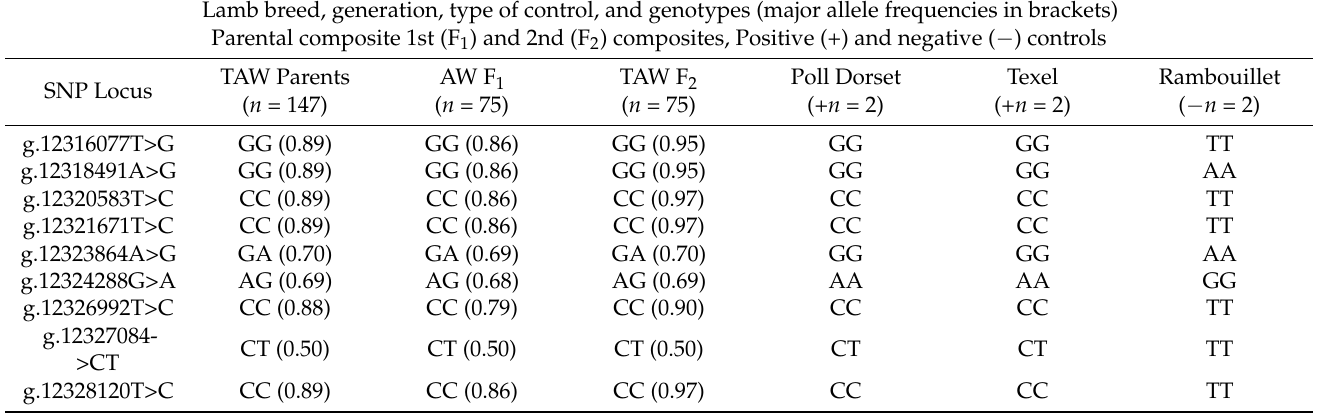
Table 3. FASN gene SNP (major allele frequency) in TAW 1 , Poll Dorset (+control) and Rambouillet ( − control) lambs. Lamb breed, generation, type of control, and genotypes (major allele frequencies in brackets) Parental composite 1st (F 1 ) and 2nd (F 2 ) composites, Positive (+) and negative ( − ) controls SNP Locus